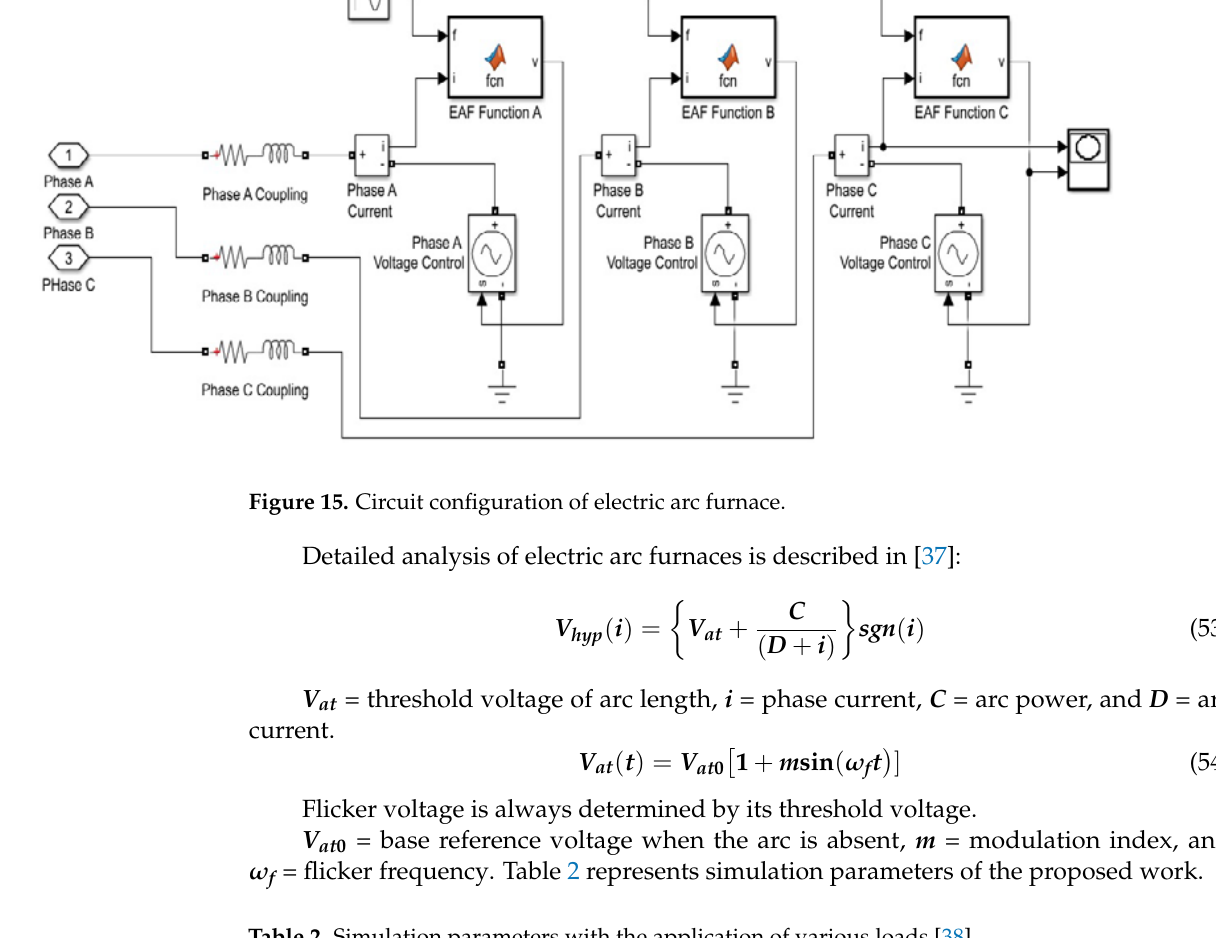
Table 2. Simulation parameters with the application of various loads